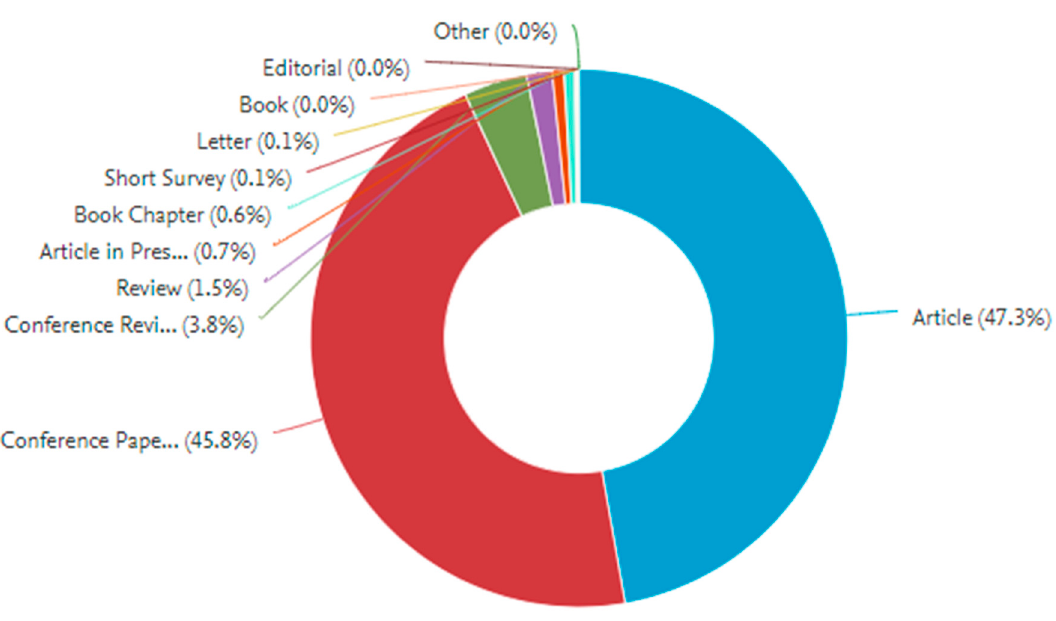
Figure 7. Literature types on the on rotating electrical machines using soft computing, from 1987–2017. (Source: Scopus & Web of Science).